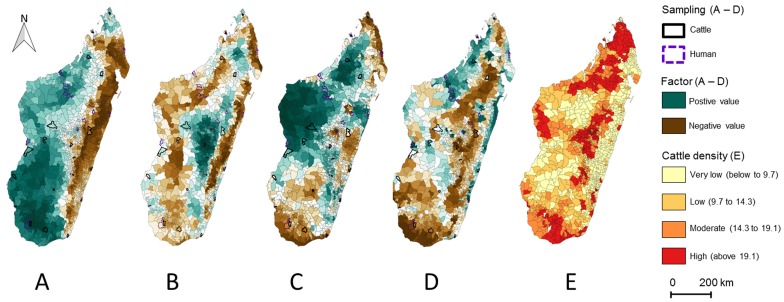
Geographical representation of the MFA factor values and cattle density of the 1,578 Malagasy communes.(A) Factor 1, (B) Factor 2, (C) Factor 3, (D) Factor 4, (E) cattle density categories. For each factor, green colors represent positive values and brown negative values. The darkest colors represent the highest values. Cattle were sampled in communes surrounded in black and human were enrolled in communes surrounded in purple.